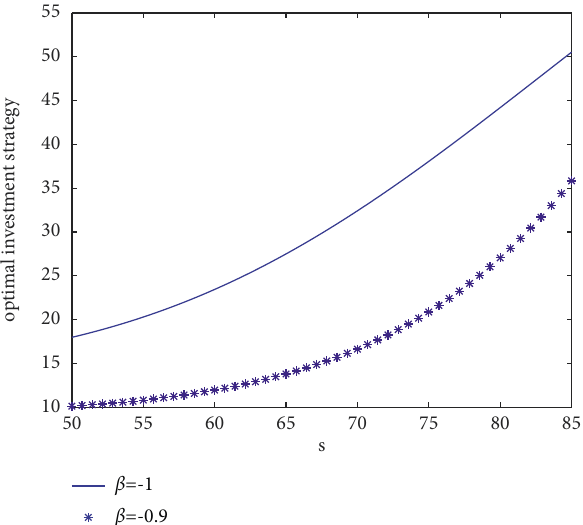
Figure 1: Effect of r on optimal investment ratio π ∗